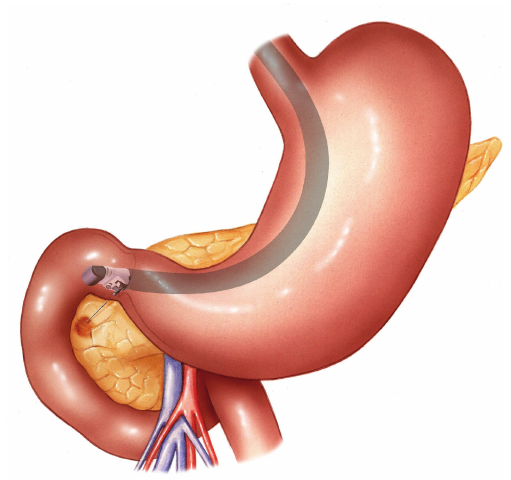
Figure 2: Cystic lesion in the pancreatic head is punctured using a linear array echo-endoscope.